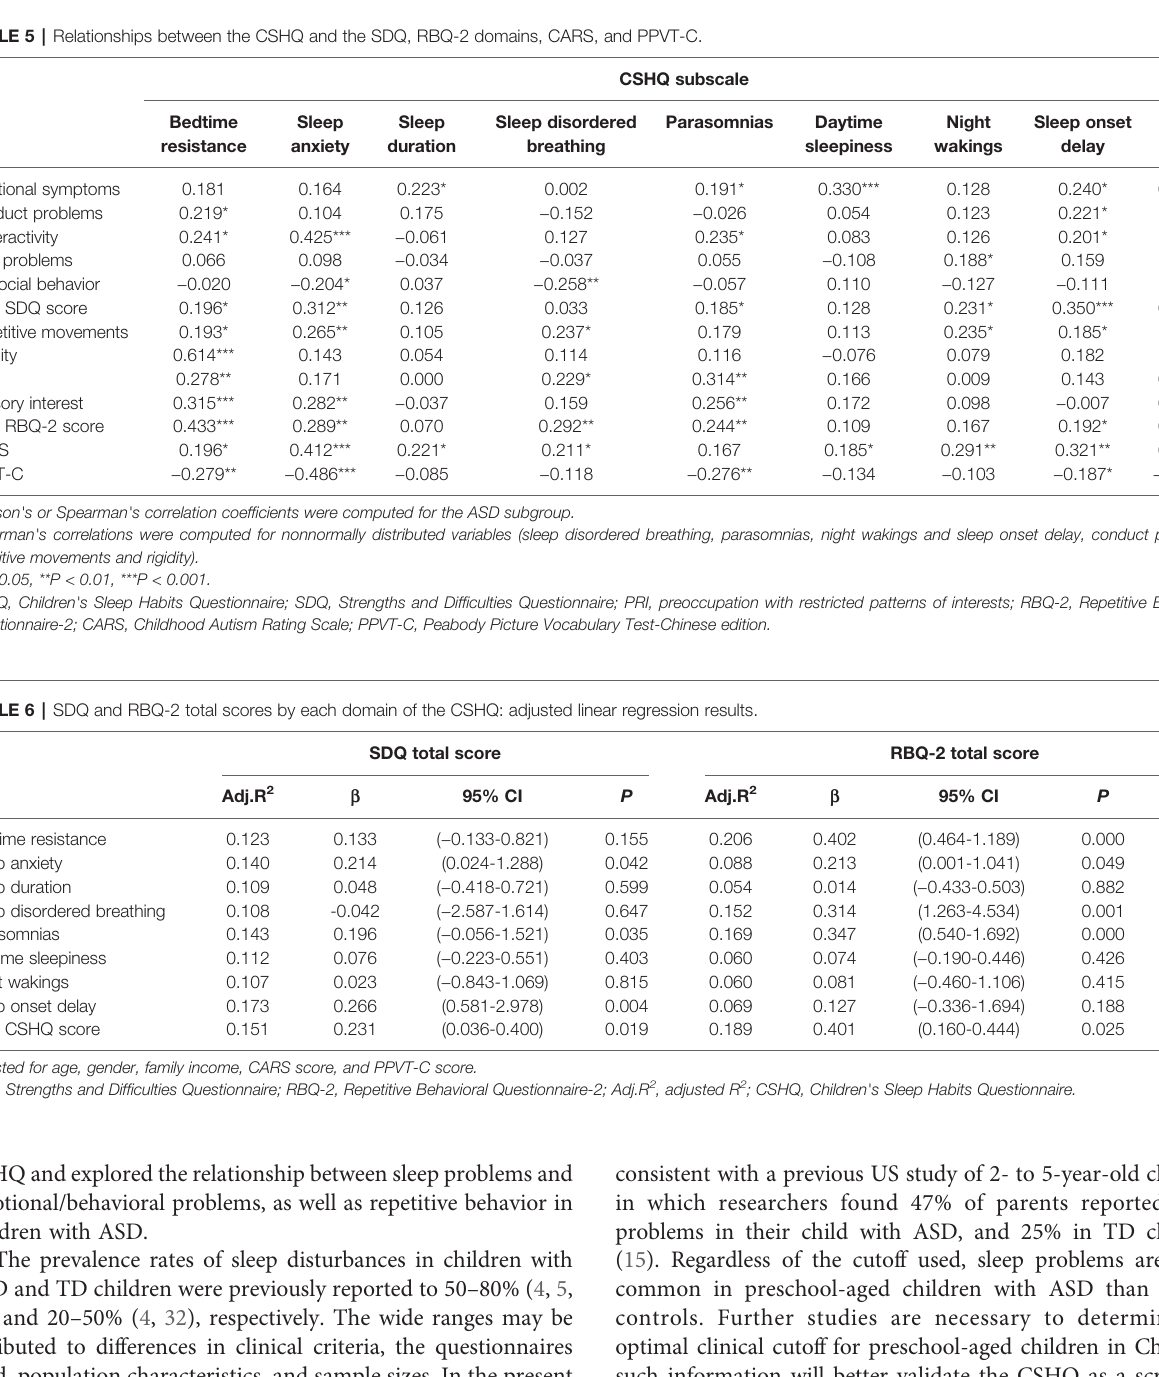
Bedtime resistance